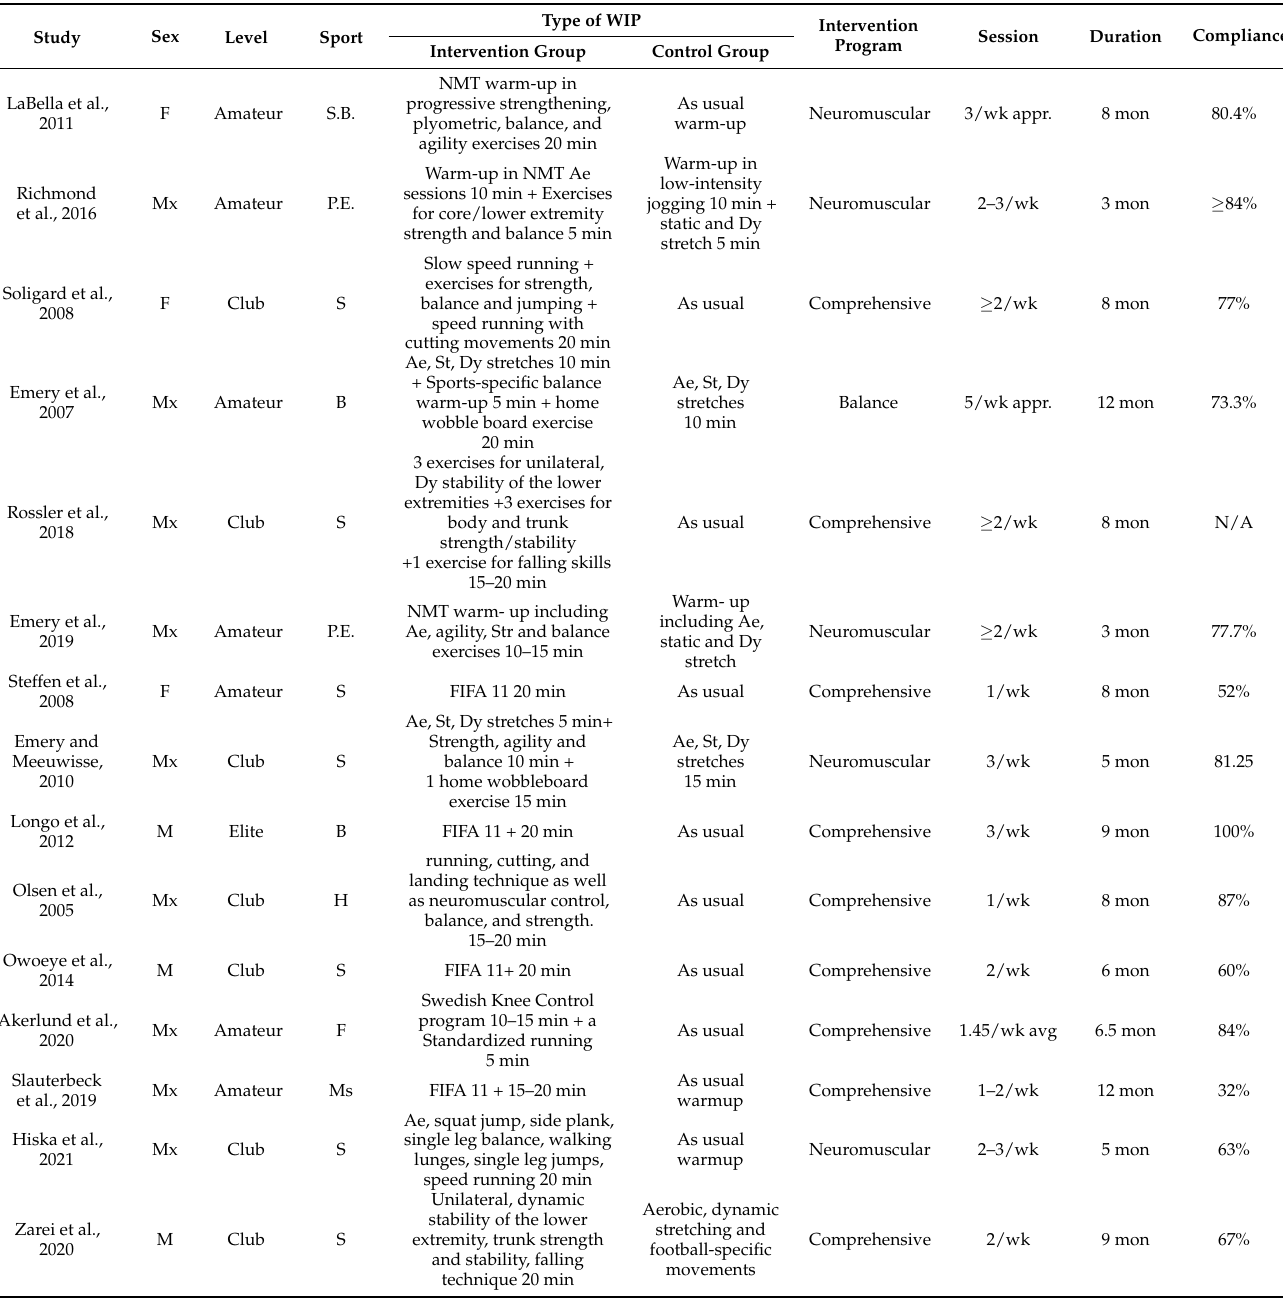
Table 3. Characteristics and Content of Identified Studies a